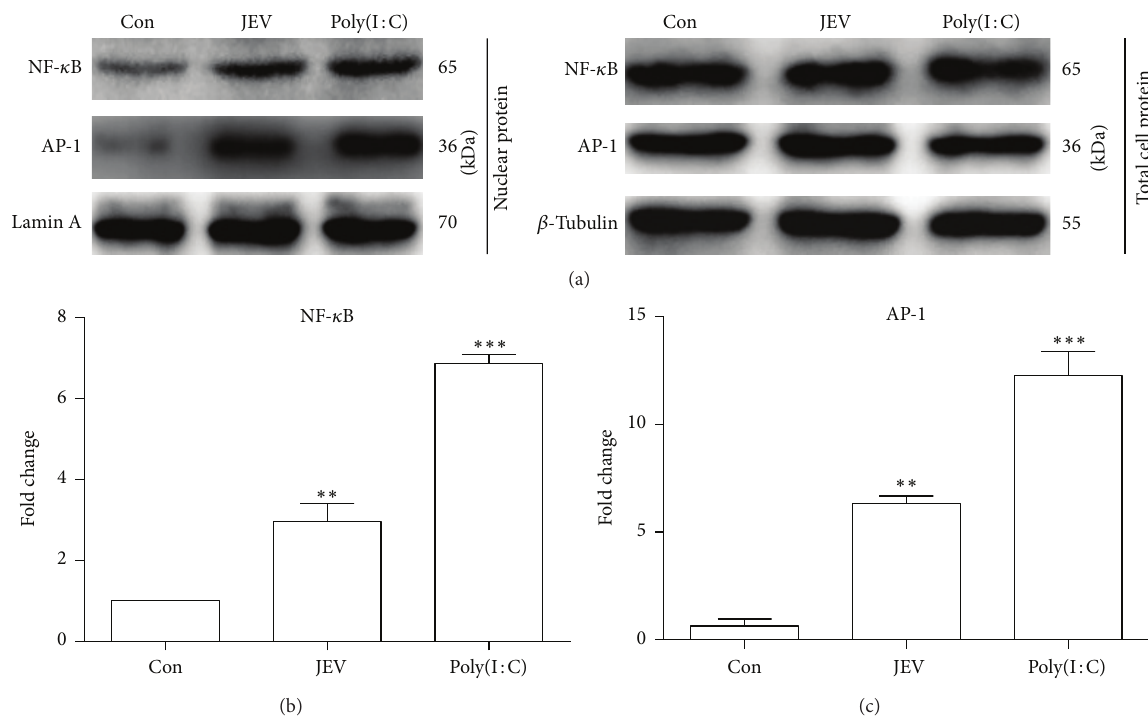
Figure 3: Nuclear localization of AP-1 and NF- 𝜅 B in JEV-infected BV-2 cells. BV-2 cells were either mock infected or infected with JEV at an MOI of 1. Poly(I: C) was added as a positive control. (a) AP-1 and NF- 𝜅 B in the nucleus and whole-cell extracts were detected with western blotting at 5 hpi. (b, c) These proteins were quantified with immunoblot scanning and normalized to the amount of lamin A or 𝛽 -tubulin. The ratios of protein levels in the nucleus to levels in whole-cell extracts were calculated. Error bars represent the standard deviation of results from three independent assays ( ∗∗ 𝑃 < 0.01 ; ∗∗∗ 𝑃 < 0.001